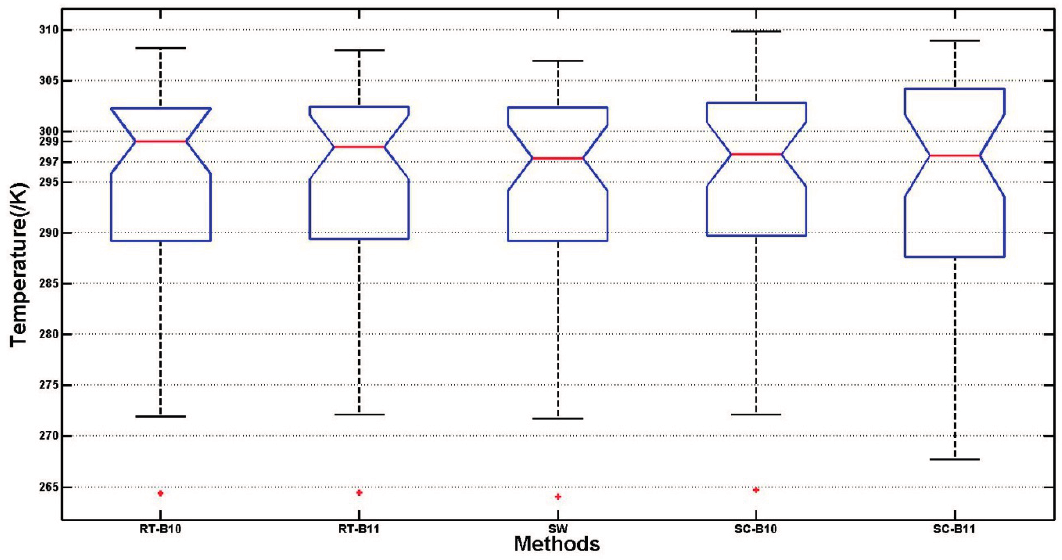
Figure 4. Box plot of three different methods (RT-B10: radiative transfer equation-based method using band 10; RT-B11: radiative transfer equation-based method using band 11; SW: Split Window algorithm; SC-B10: Single Channel Method using band 10; SC-B11: Single Channel Method using band 11).